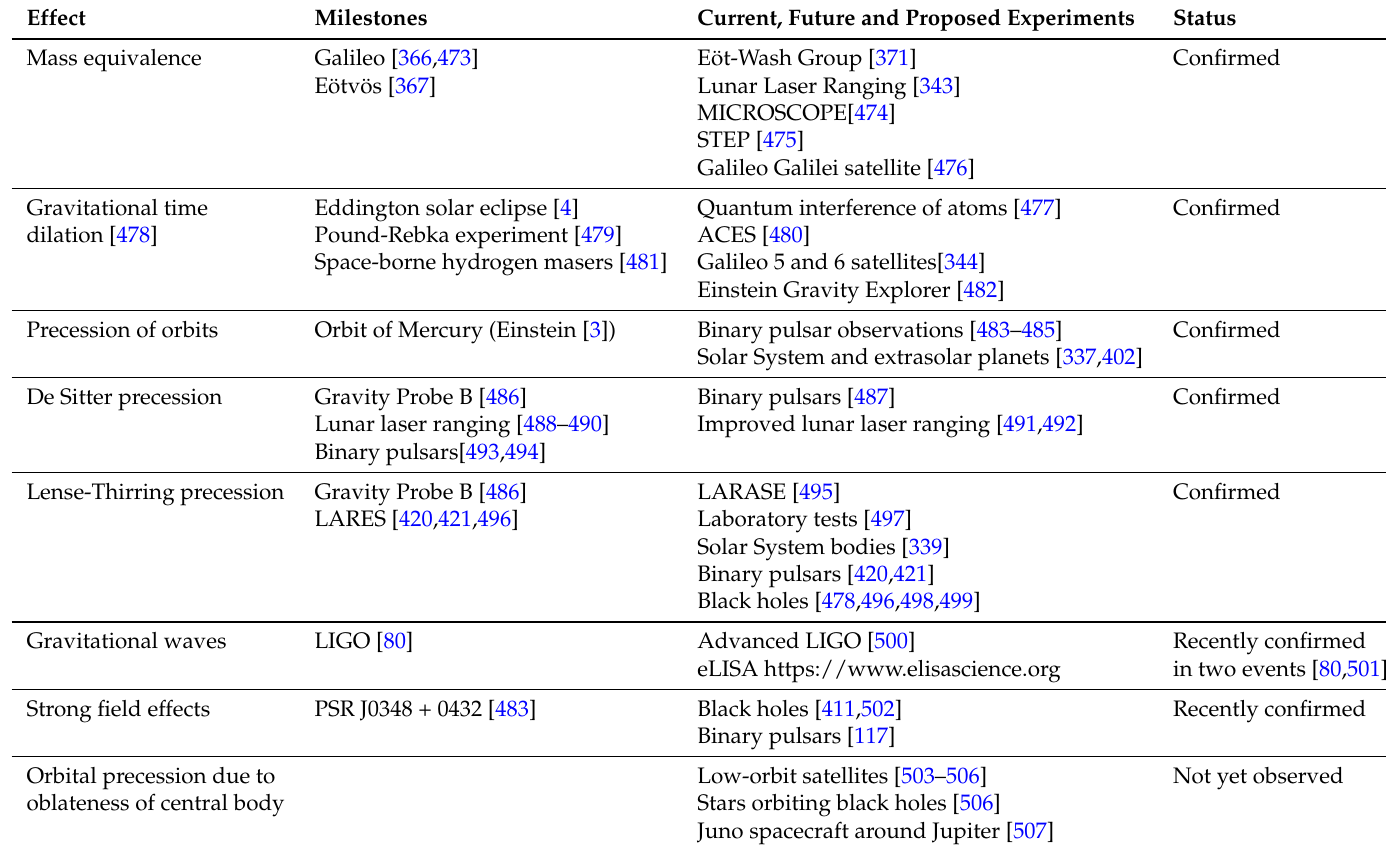
Table 6. The major predictions of GR, and their experimental